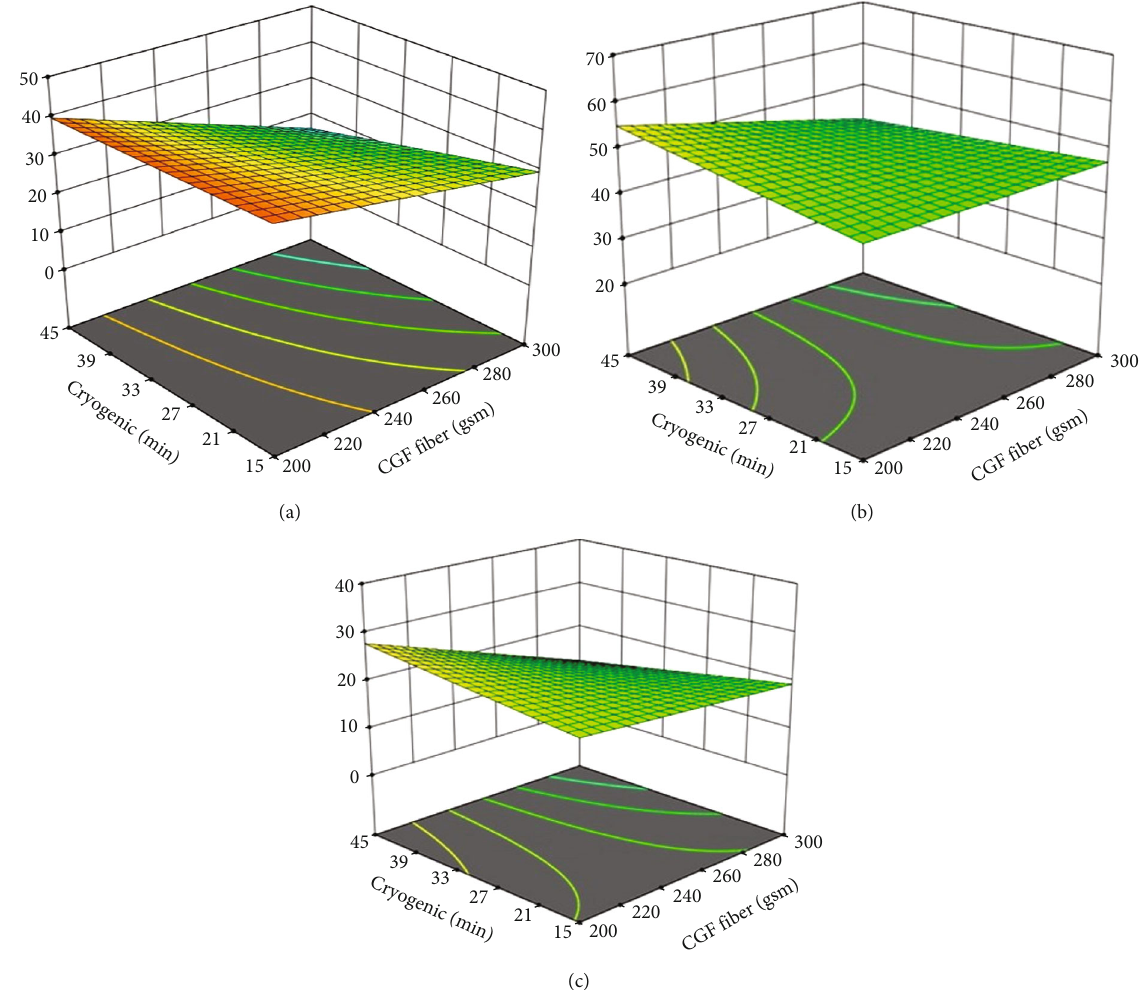
Figure 7: Surface plot of cryogenic treatment on the nanocomposites. (a) Tensile, (b) fl exural, and (c) impact